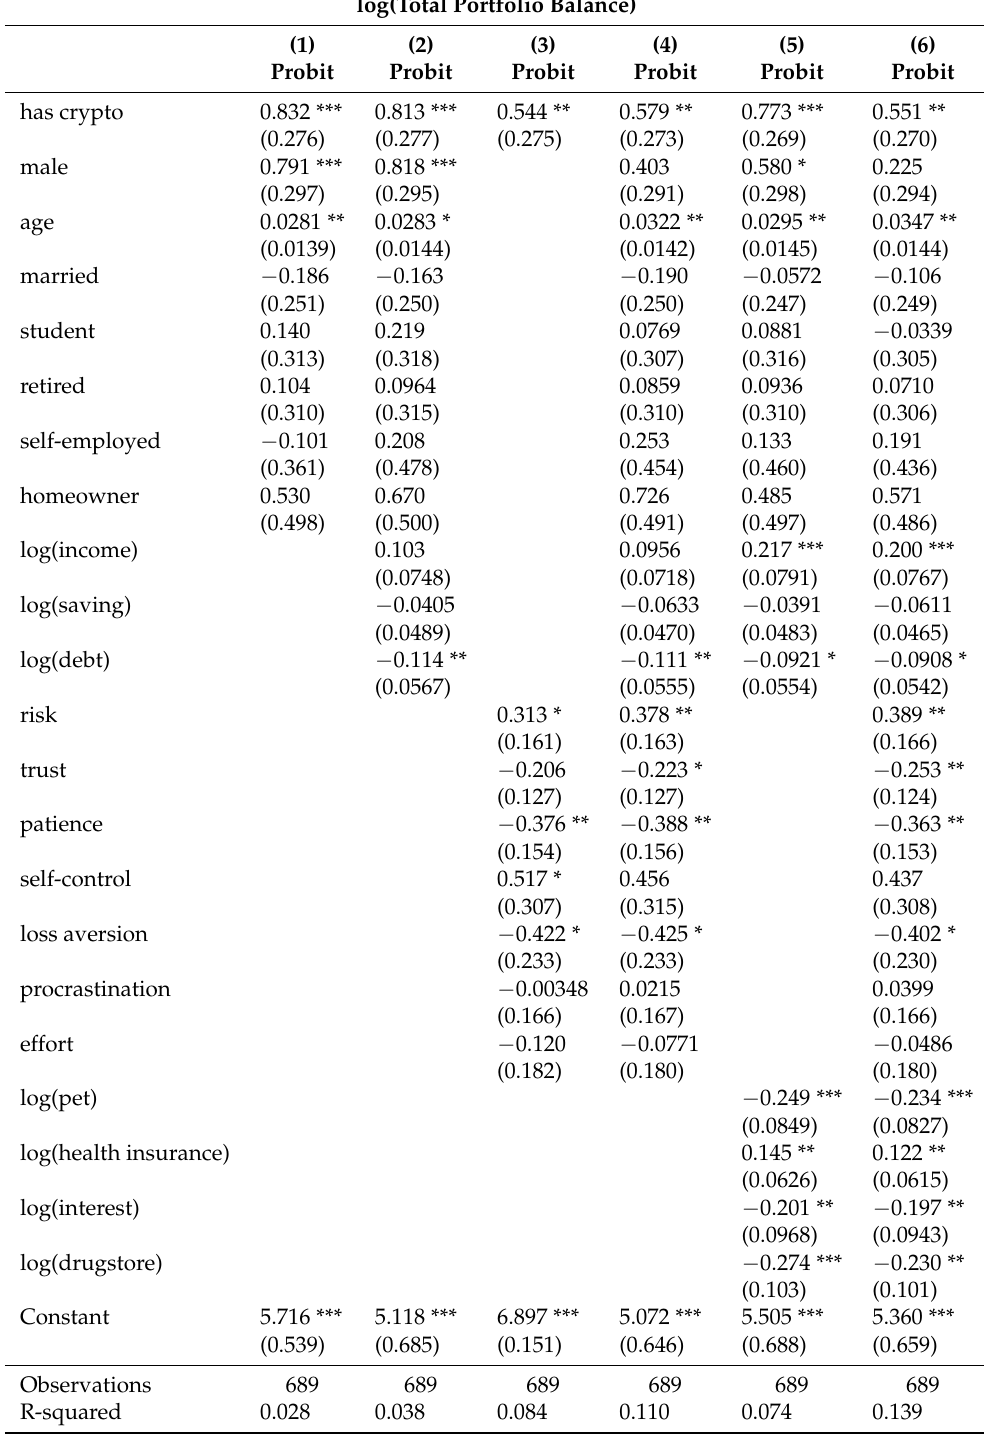
Table A11. OLS regression of portfolio balance including crypto ownership. Source: Own